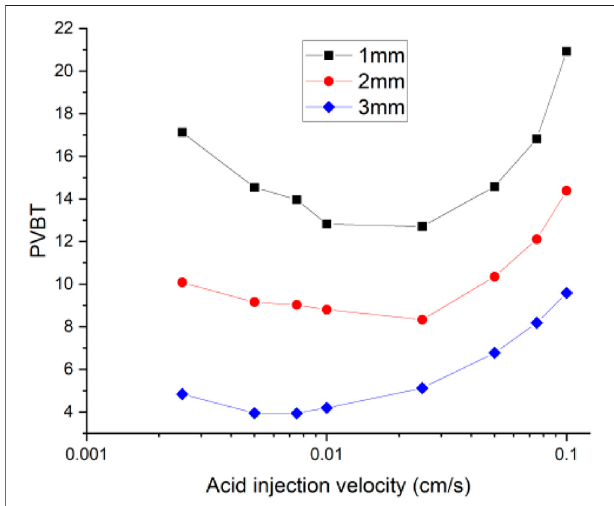
FIGURE 8 | Isolated fracture acidizing curves of pore volume to breakthrough with different apertures.